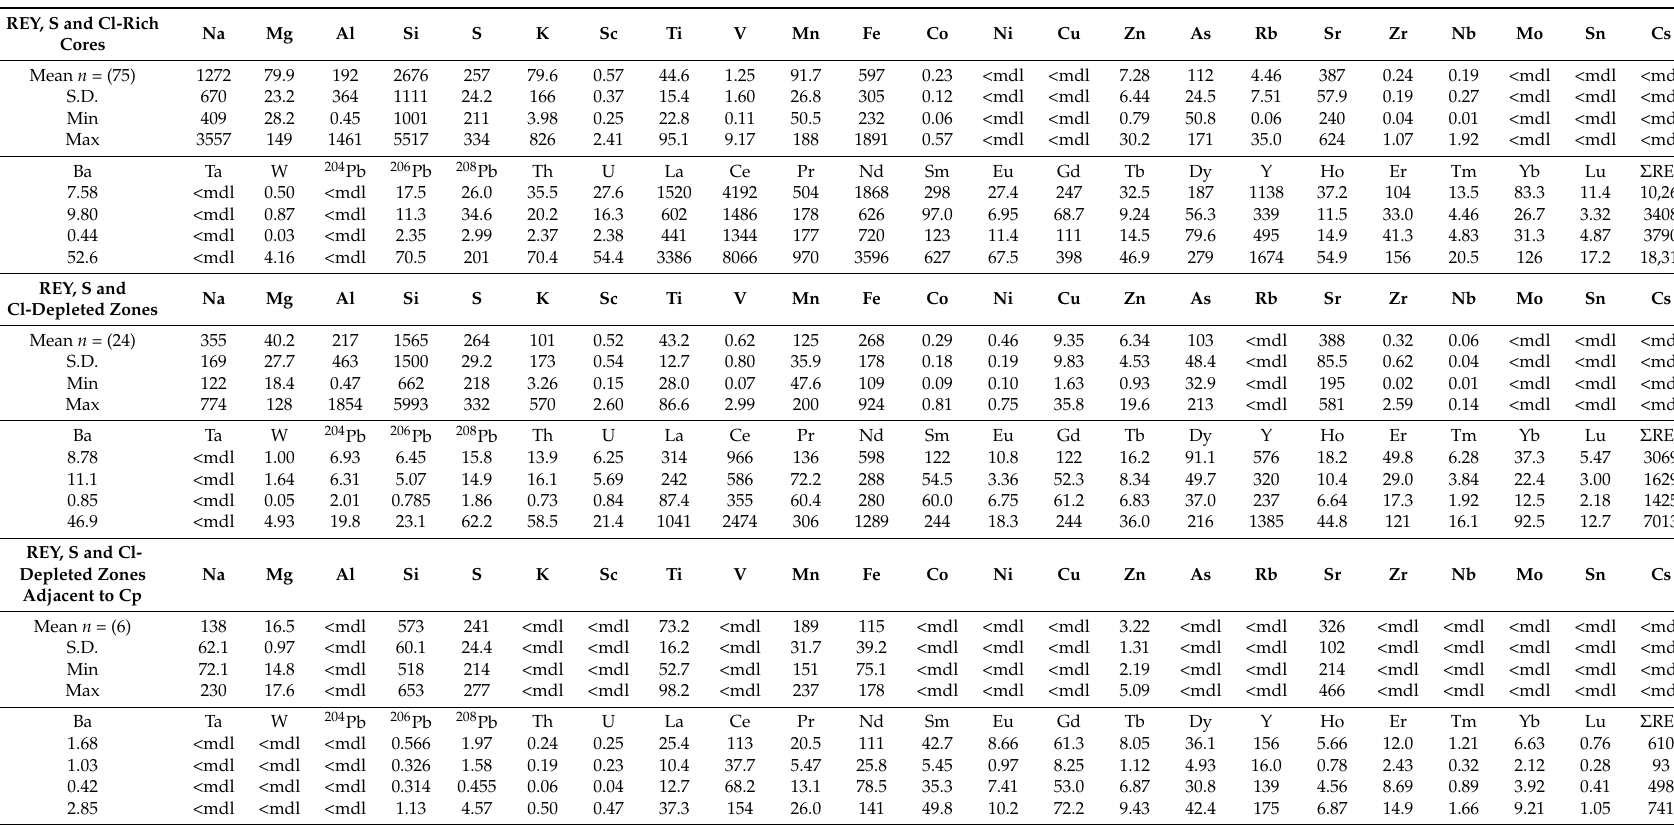
Table 5. REE and trace element concentrations in apatite from the Deep Mineralization (ppm). Apatite analyses were performed on multiple grains in the following samples: REY, S and Cl-rich cores—2773-1, -2, -3, -4, -5; REY, S and Cl-depleted zones—2773-1, -2, -5; REY, S and Cl-depleted zones adjacent to Cp—2773-4. <mdl—below minimum detection